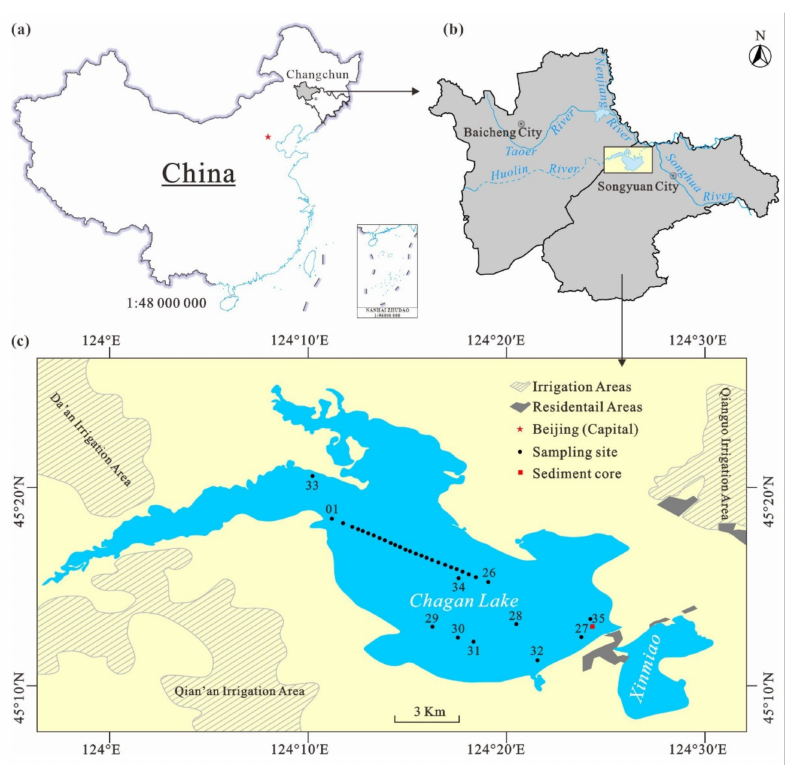
Figure 1. Geographic setting of Chagan Lake ( a , b ) and detailed view of sampling locations ( c